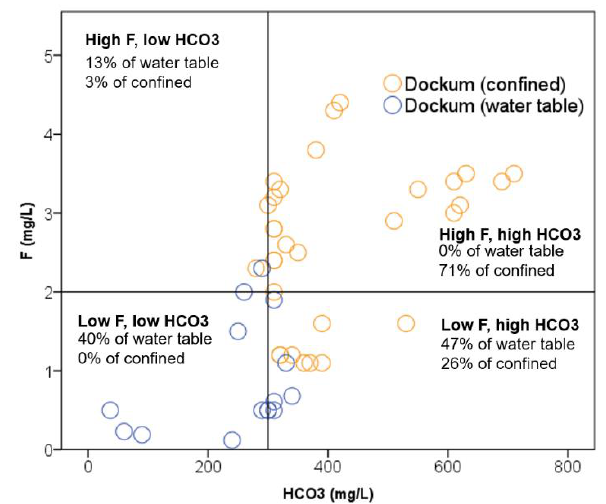
Figure 12. Breakdown of two major contributors to F3 illustrating how levels of fluoride and bicarbonate relatively contribute to differentiation between the groundwater types.